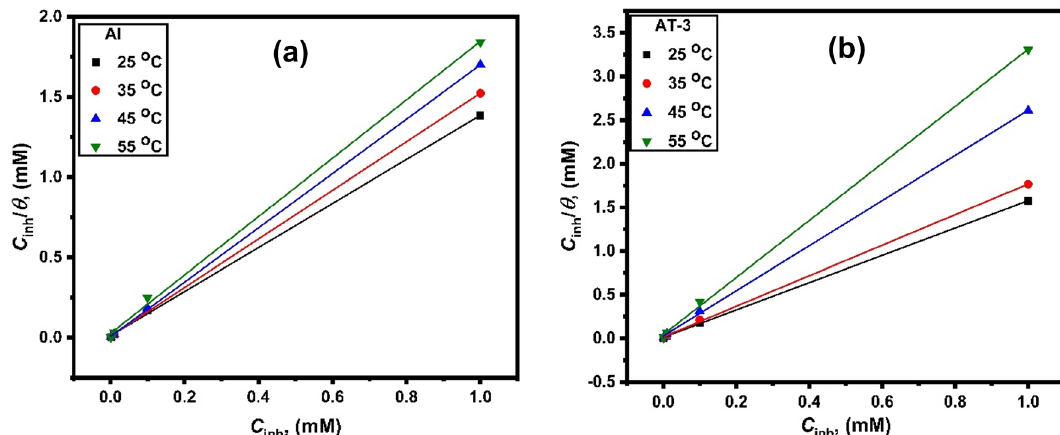
Figure 10. Fitting of Langmuir adsorption model ( C inh / θ versus C inh ) based on the data attained from measurements of Tafel polarization for ( a ) Al and ( b ) AT-3 alloy in 0.5 M HCl solution comprising various concentrations of 2-MBT at different temperatures.